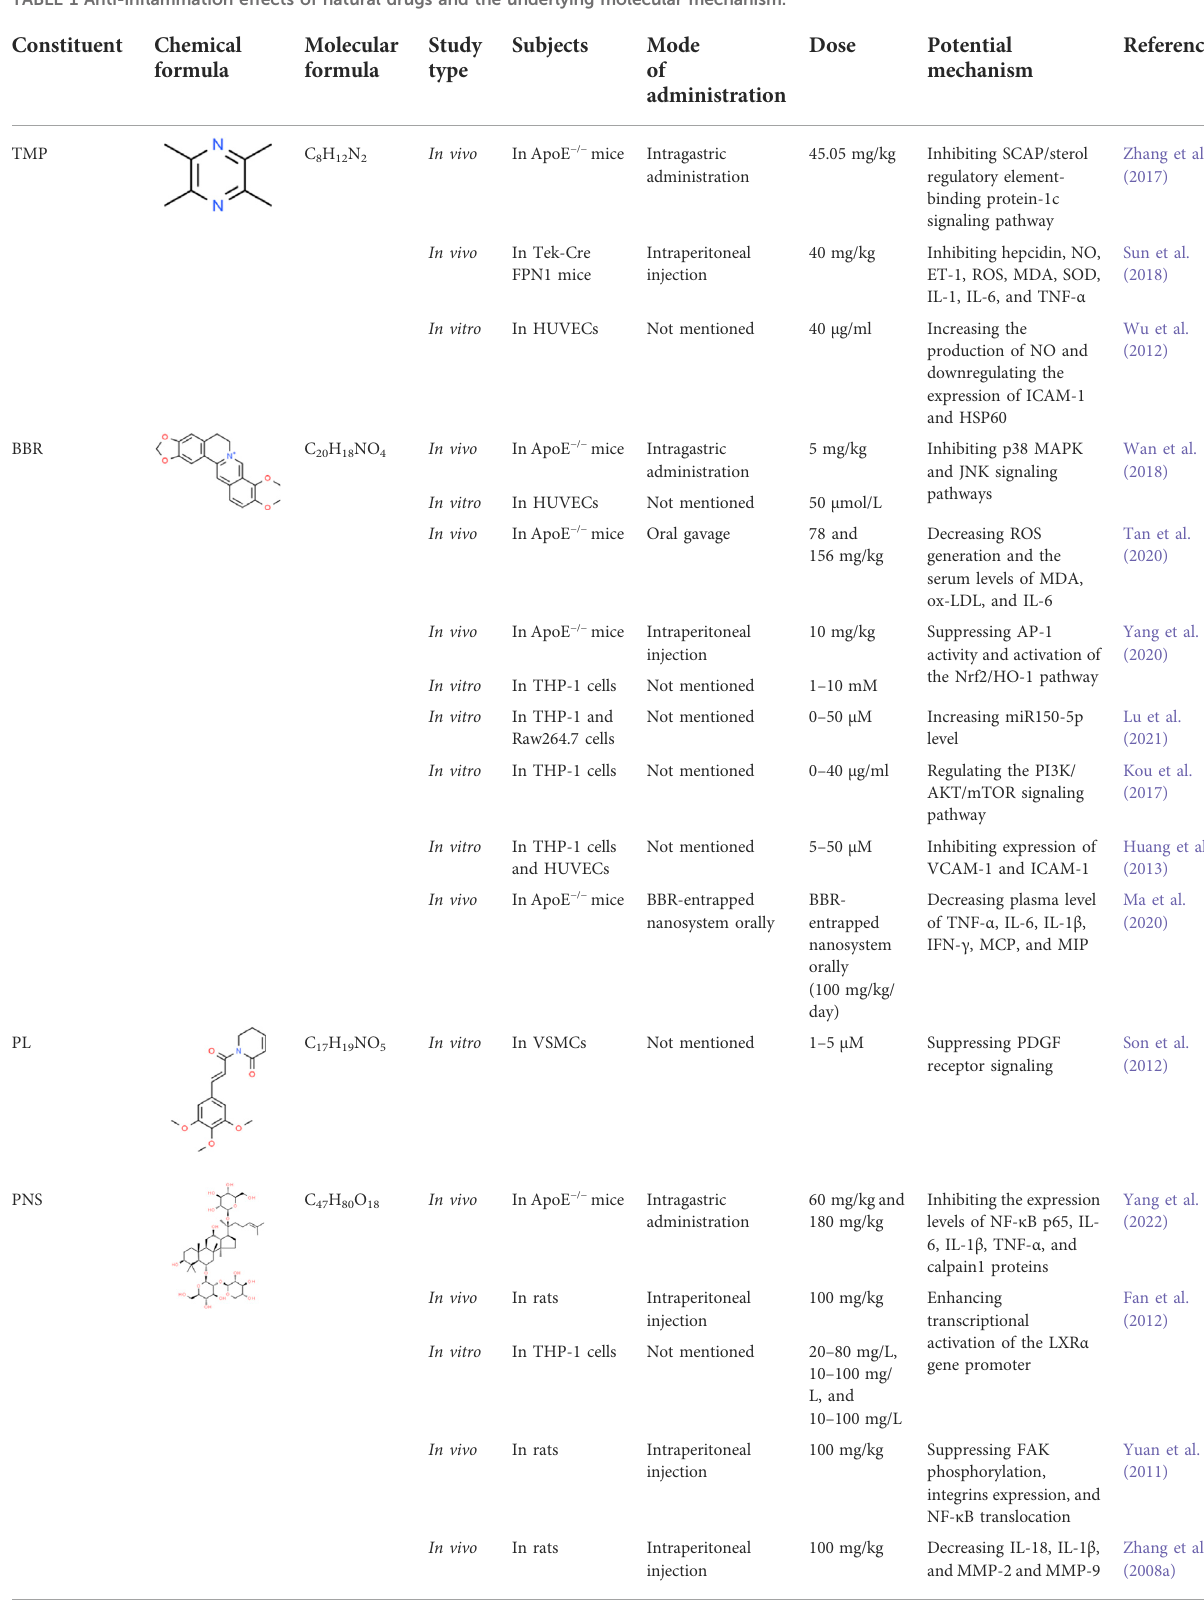
TABLE 1 Anti-in fl ammation effects of natural drugs and the underlying molecular